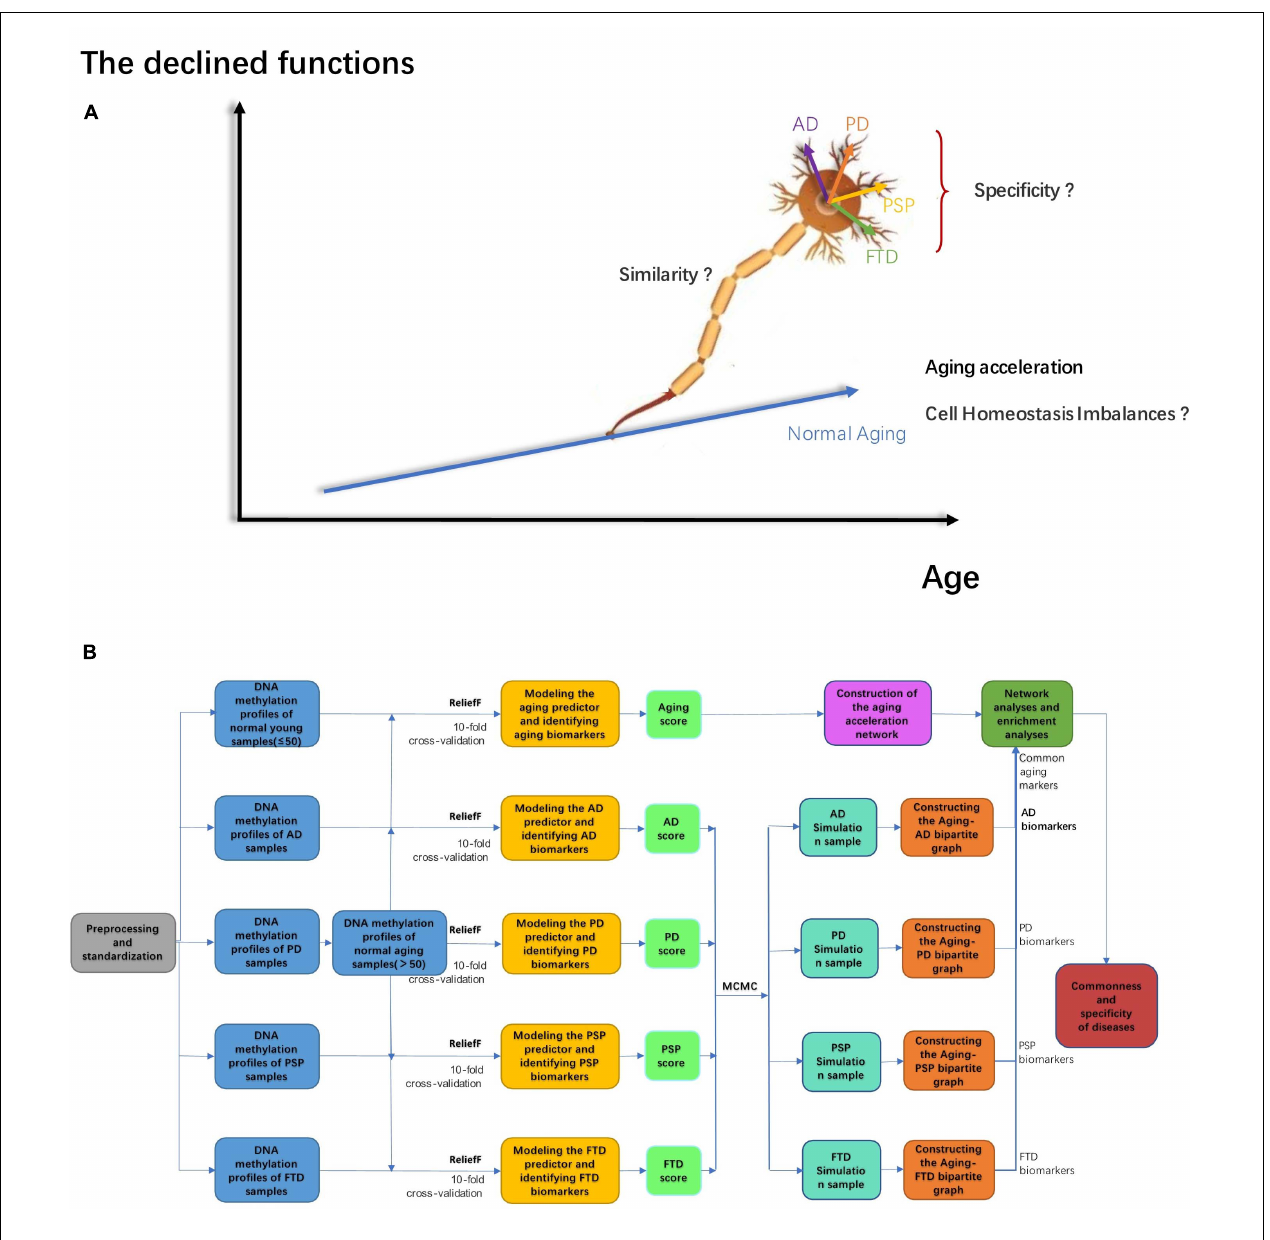
FIGURE 1 | (A) The mechanism hypothesis diagram of ND; (B) the workflow in our work. TABLE 1 | Accuracy of aging and disease